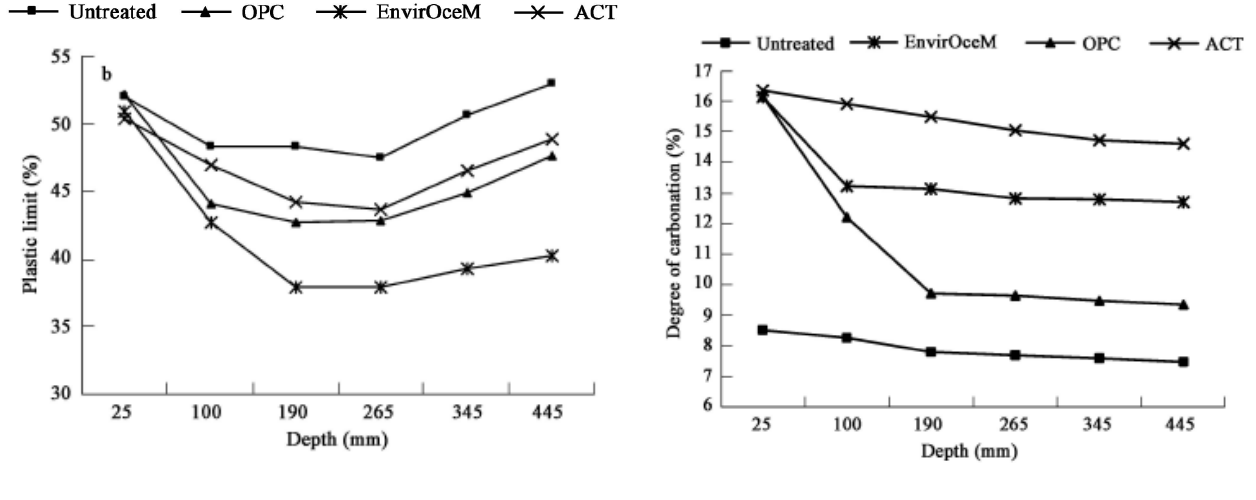
Figure 12. Degrees of carbonation of the soils according to the depth in the four cells: ACT soil > EnvirOceM soil > OPC soil > Untreated soil (from Jiangying et al . [38] with permission of Elsevier